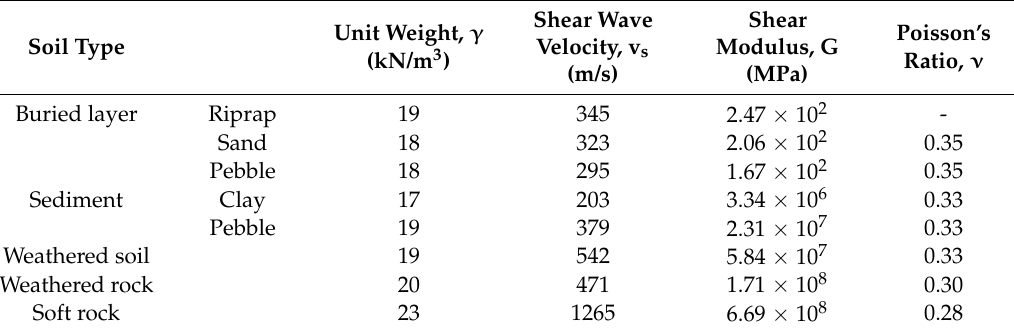
Table 3. Soil investigation at the crane location.